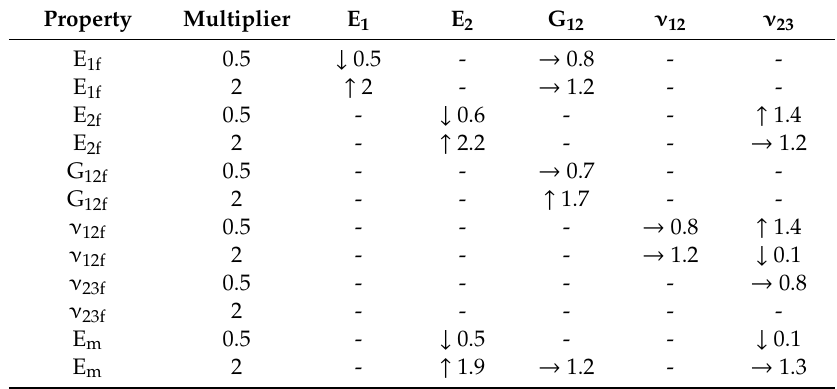
Figure 7. Image-based meshing of the microstructure showing a perspective view of the fiber and interphase. Table 3. Sensitivity of homogenised composite properties to fiber and resin properties.